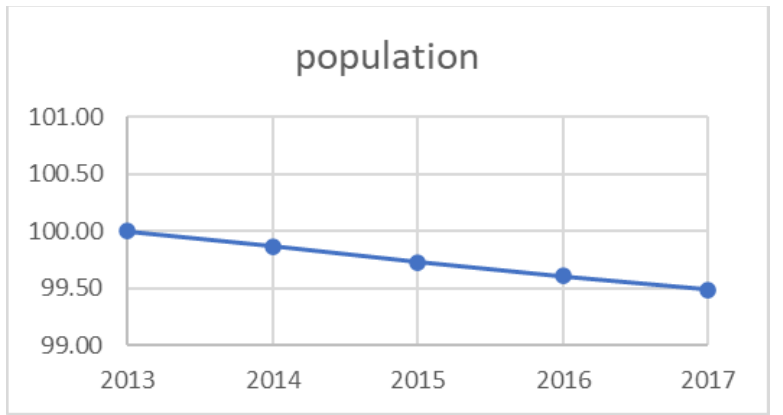
Figure 16. Italian population growth trend from 2013 to 2017. The 2013 value (59701104) is set to 100%.